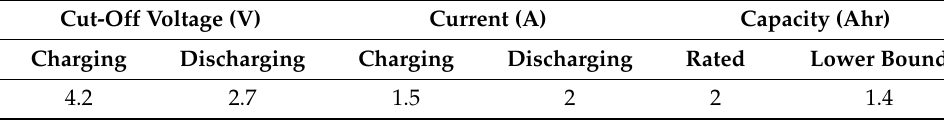
Table 1. Operating conditions for charging and discharging process.